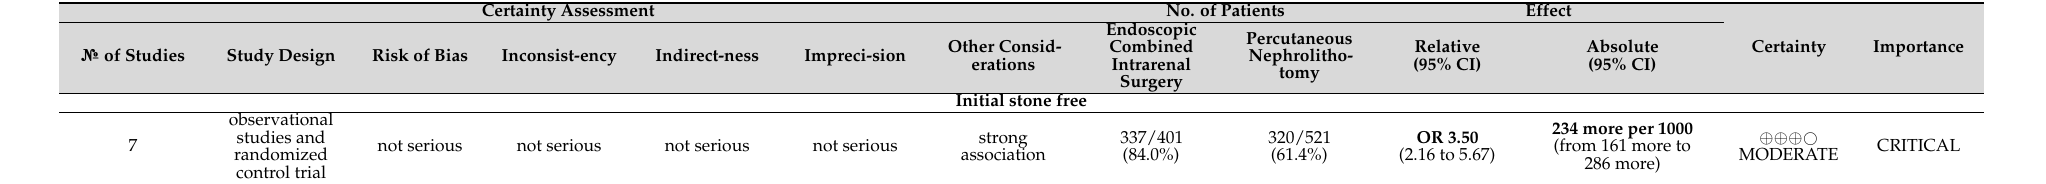
Table A7. GRADE Approach for Rating the Quality of Treatment Effect Estimate